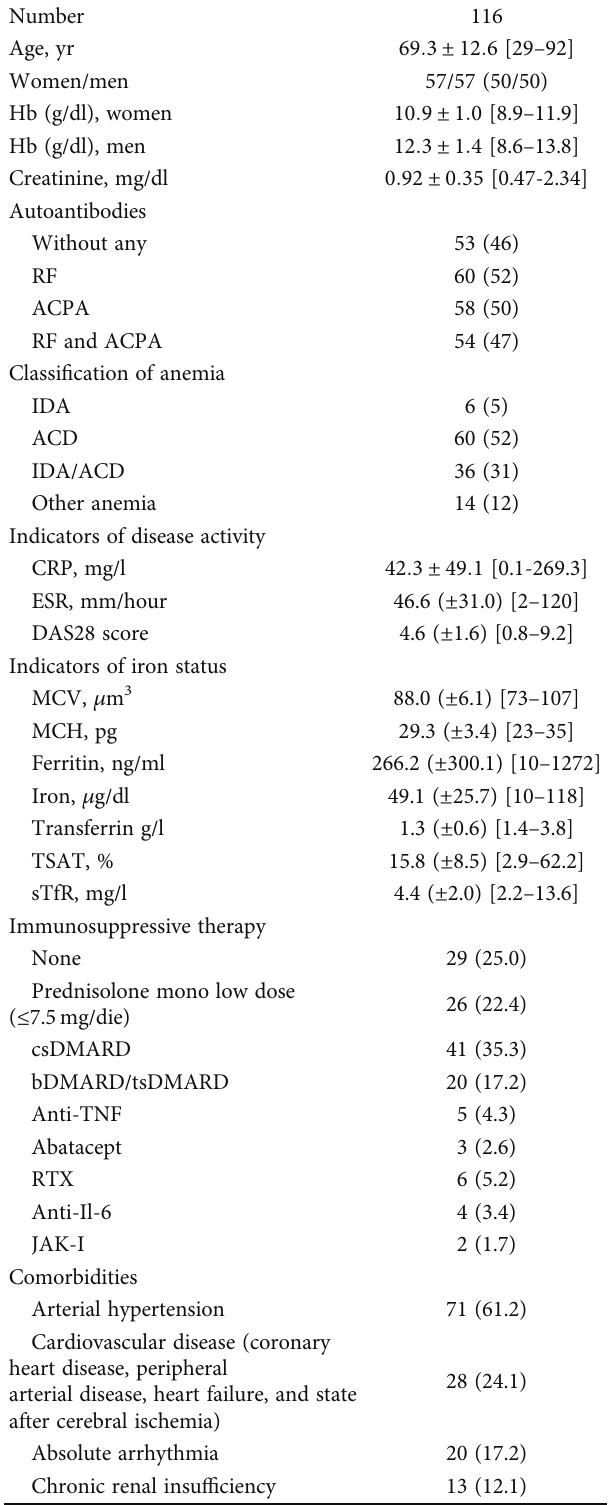
Table 1: Characteristics of patients under study. Data are given as means ± SD . Ranges are given in brackets and percentages in